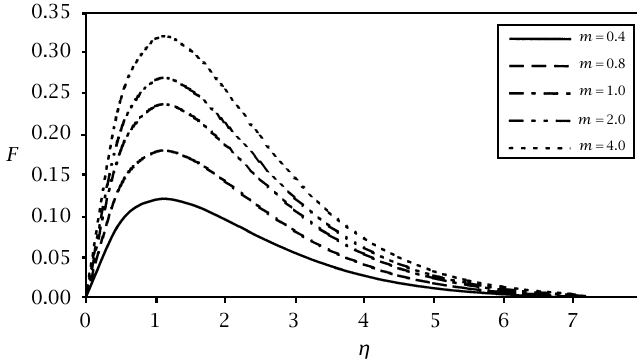
Figure 3.4 . The variation of F against η for M = 0 . 2 and R =